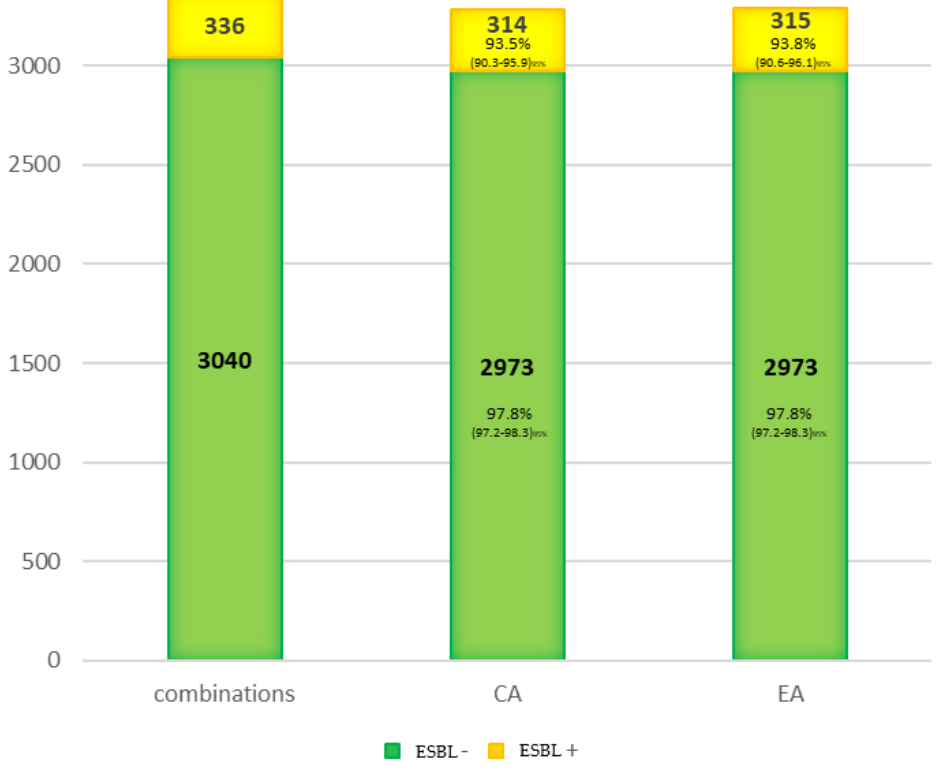
Figure 2. Concordance for the ESBL